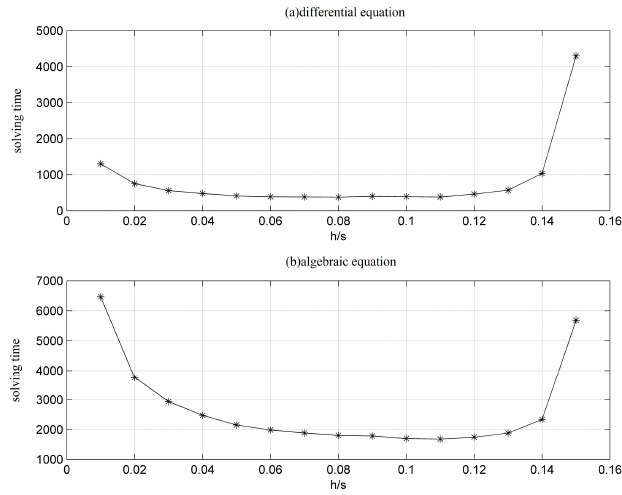
Figure 9. The amount of computing for differential algebraic equations in case B.